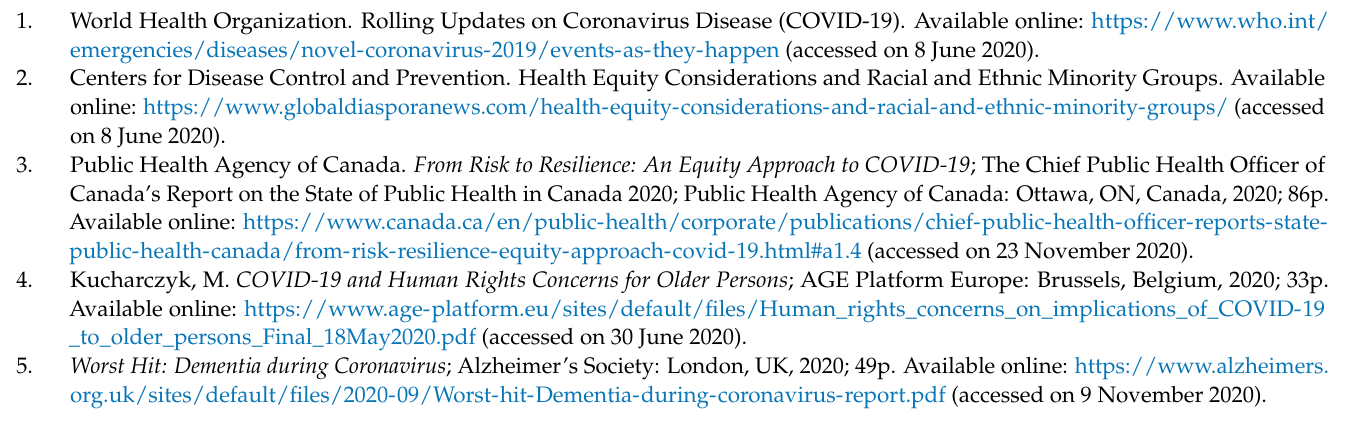
Table A5. Cont. Population (individuals who may experience significant unintended health impacts (positive or negative) as a result of services/resources impacted by COVID) Indigenous Peoples (e.g., First Nations, Inuit, M é tis, etc.) Disability (e.g., physical, D/deaf, deafened or hard of hearing, visual, intellectual/developmental, learning, mental illness, addictions/substance use, etc.) Ethno-racial communities (e.g., racial/racialized or cultural minorities, immigrants and refugees, etc.) Low income (e.g., unemployed, underemployed, etc.)